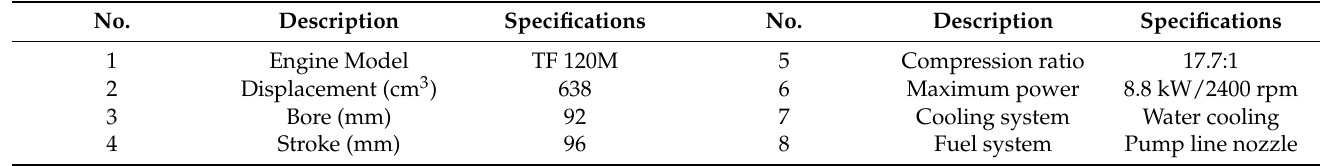
Table 4. Specifications of diesel engine [50] (Adapted with permission from the Elsevier).